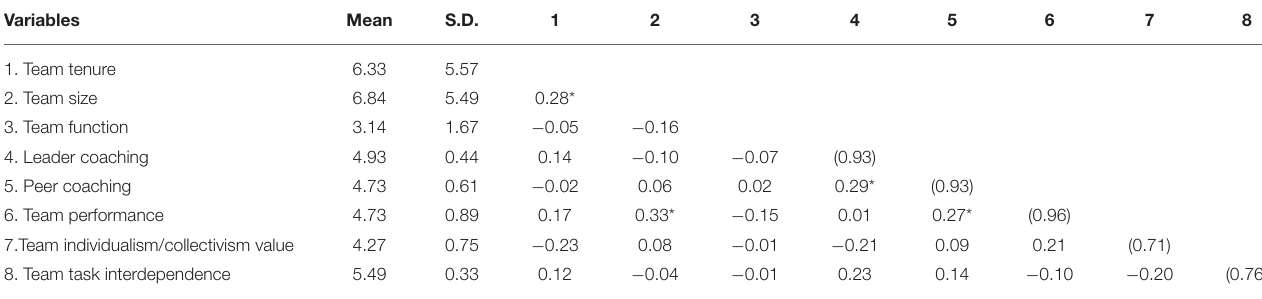
TABLE 1 | Descriptive statistics and correlations. Variables